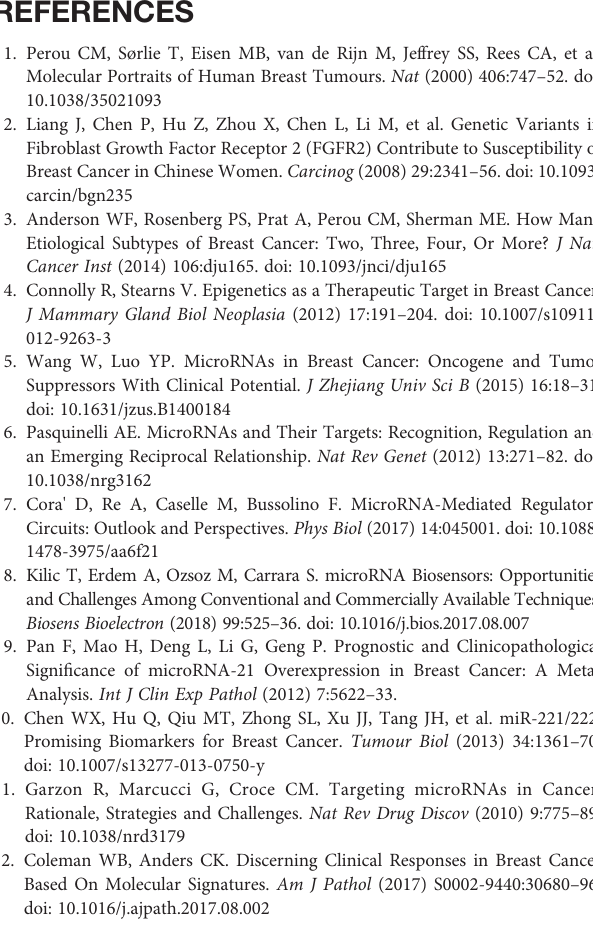
respectively. Up-regulated miRNAs are marked with a red thermometer and downregulated with a blue thermometer. Red arrows indicate an inhibition effect, and green arrows indicate an activation effect. Supplementary Figure 3 | Interaction maps in breast cancer miRNome. Representative interaction maps generated by MetaCore ™ software in (A) PTEN network from DE miRNAs and (B) the interaction map of miR-205-5p. Up-egulated miRNAs are marked with red circles, and downregulated miRNAs are marked with blue circles. The ‘ checkerboard ’ color indicates mixed expression for the gene between fi les or between multiple tags for the same miRNA. Supplementary Figure 4 | Heatmap of 15 differentially expressed miRNAs among BC cell lines con fi rmed in BC subtypes (TCGA). Supplementary Table 1 | miRNAs differentially expressed in the MCF7 cell line. Supplementary Table 2 | miRNAs differentially expressed in the EVSA-T cell line. Supplementary Table 3 | miRNAsdifferentiallyexpressedintheHCC-1954cellline. Supplementary Table 4 | miRNAs differentially expressed in the MDA-MB-231 cell line. Supplementary Table 5 | 54 DE miRNAs according to aggressiveness among BC